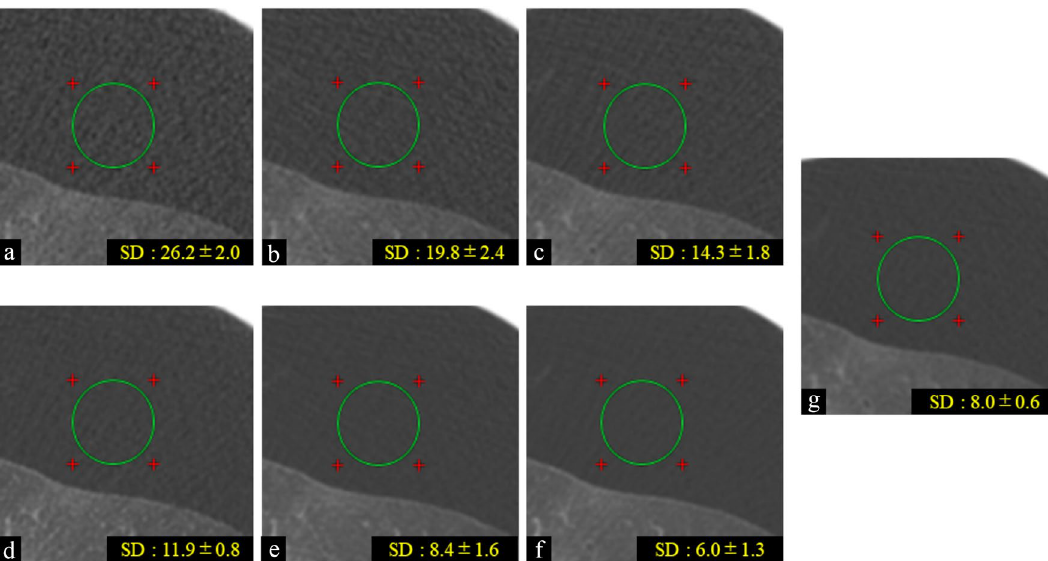
Figure 4. Images of filtered back projection (FBP) at 10 ( a ), 25 ( b ), 50 ( c ), and 175 mAs ( g ) and True Fidelity Image (TFI) at 10 ( d ), 25 ( e ), and 50 mAs ( f ) of cadaveric lung (diffuse alveolar hemorrhage). We set ROI of the same size at the same location on the selected FBP and TFI images in background air. The SD values of each image are presented. The SD values of 25 mAs-TFI were almost the same as that of 17 5